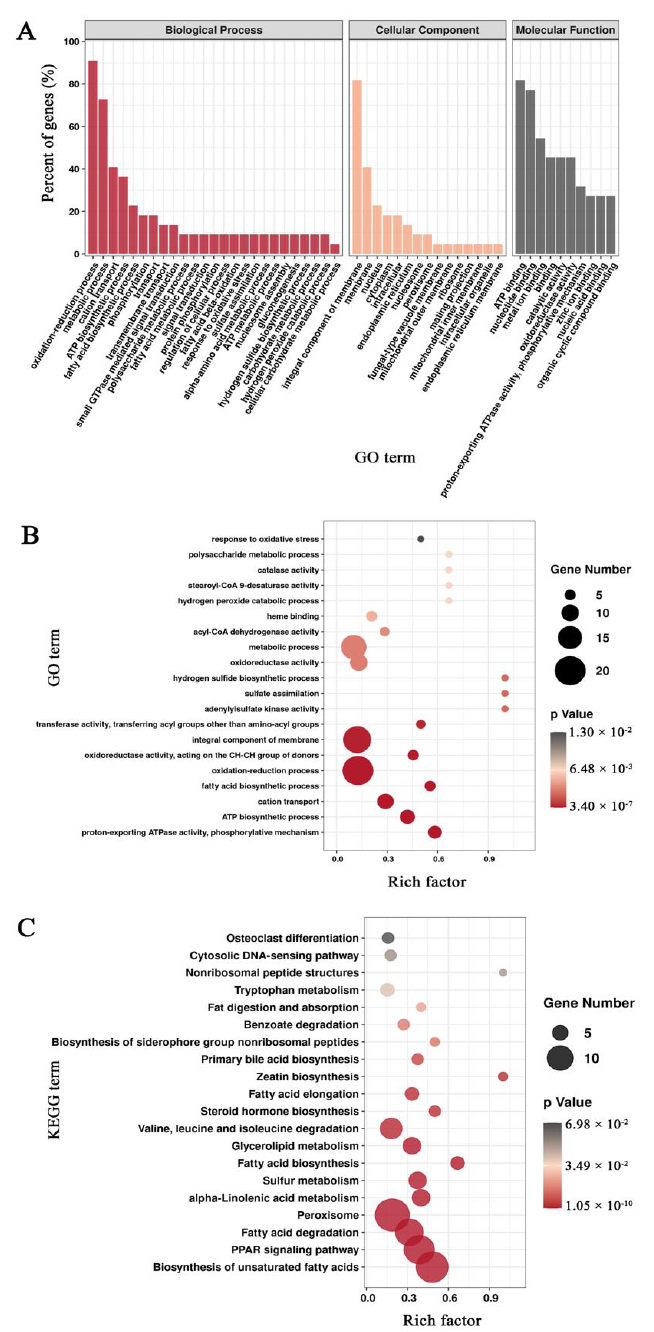
Figure 6. GO ( A , B ) and KEGG ( C ) enrichment analyses of differentially expressed genes (DEGs) derived from the TA vs. TC comparison of Mortierella alpina .